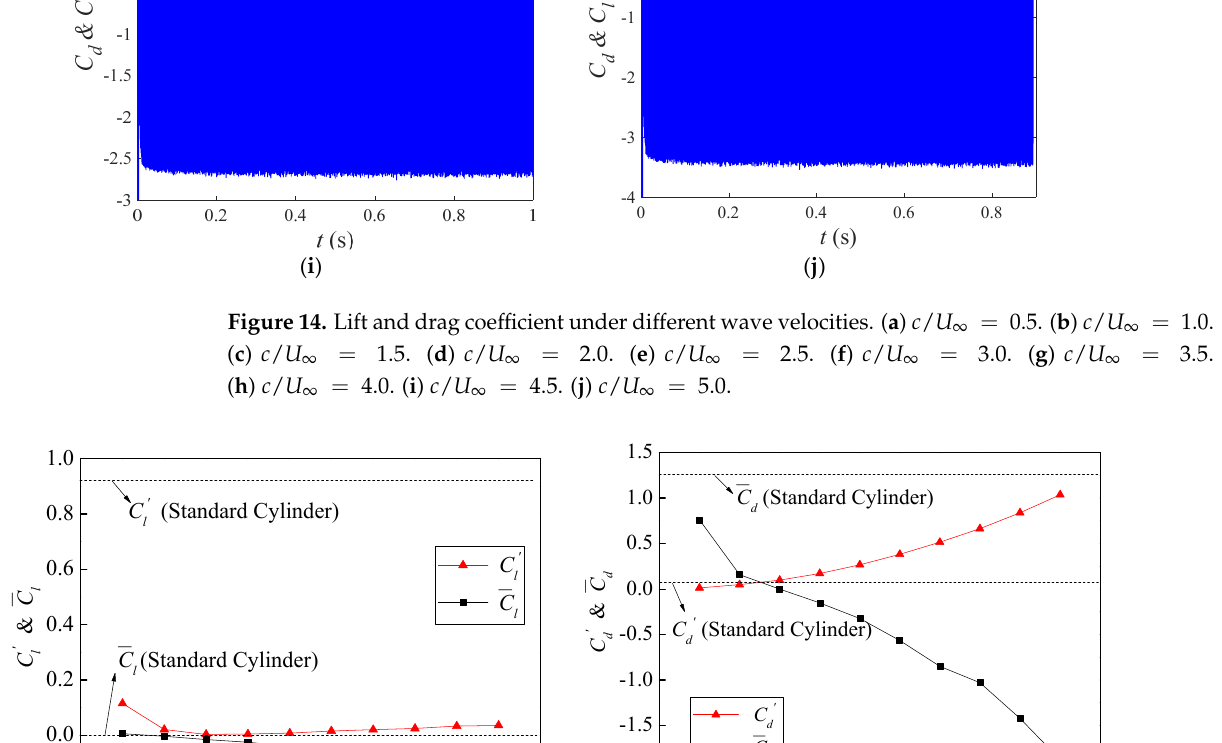
Figure 14. Lift and drag coefficient under different wave velocities. ( a )